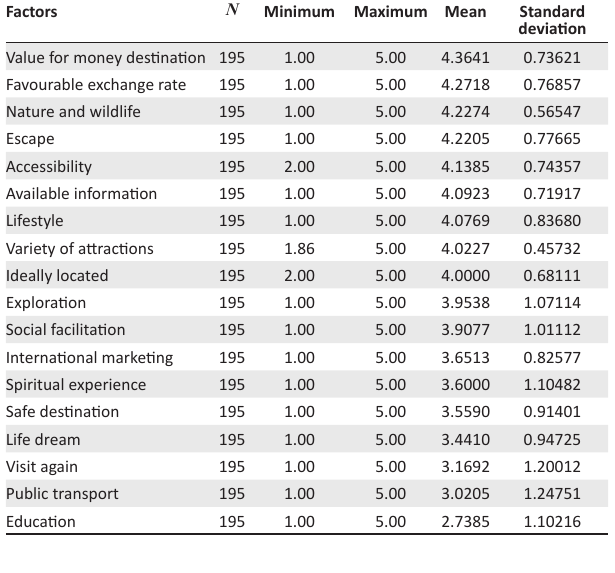
TABLE 3: Descriptive statistics of individual factors.